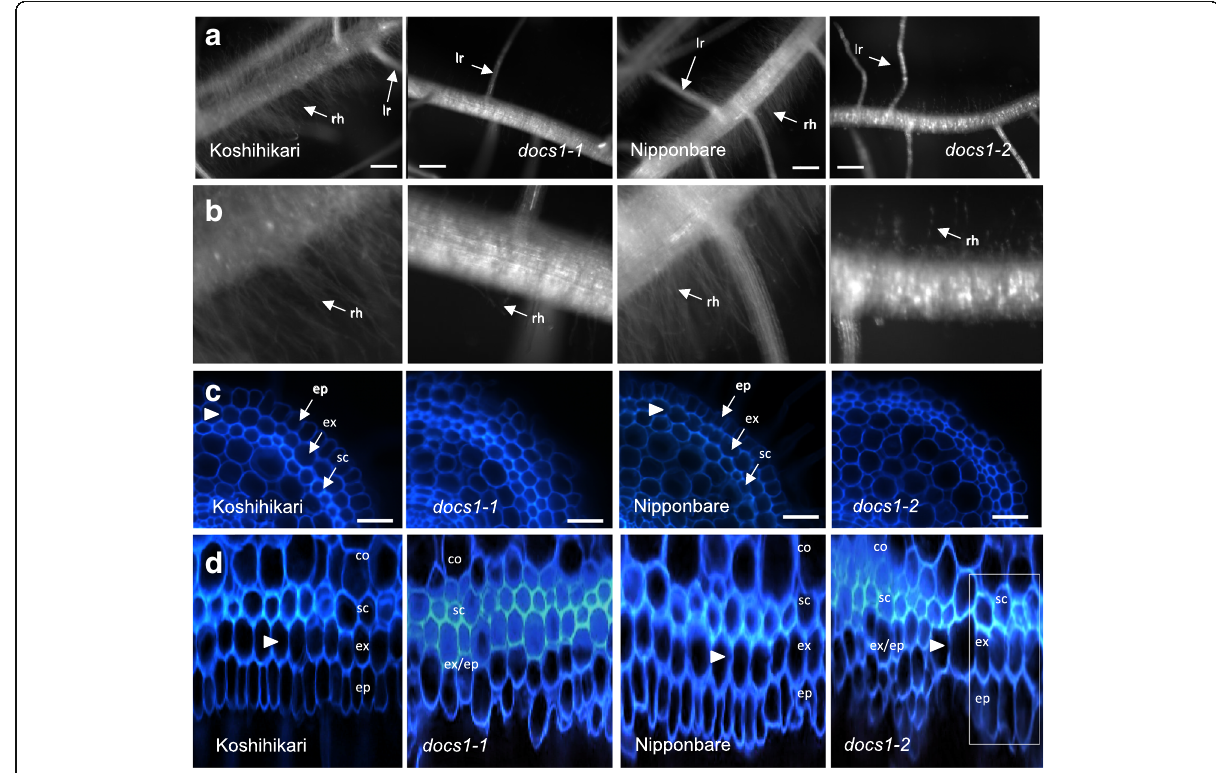
Fig. 2 docs1 – 1 and docs1 – 2 root mutant phenotypes compared to their respective Koshihikari and Nipponbare controls. a Root hairs of docs1 – 1 and docs1 – 2 mutant roots are much shorter and less abundant than their respective controls. lr, lateral root; rh, root hairs. Bars 1 mm. b Enlarged views of the root hair zones from ( a ). c Organization of outer root cell layers (epidermis (ep), exodermis (ex) and sclerenchyma (sc)) are affected in docs1 – 1 and docs1 – 2 mutant roots as observed on root cross-sections. The exodermis layer is characterized by a decreased of UV fluorescence on their radial cell walls due to Casparian strip presence (white arrowheads). Bars 20 μ m. d Disorganization of outer layers is highlighted on polar views of the root cross-sections. Full images of these polar views made with the imageJ software (Lartaud et al. 2015) are displayed in Additional file 1: Figure S1. The white box in the docs1 – 2 polar view highlights a zone where the three outer cell layers are less disorganized and where the exodermis and epidermis cell layers seem to have differentiated normally. co,